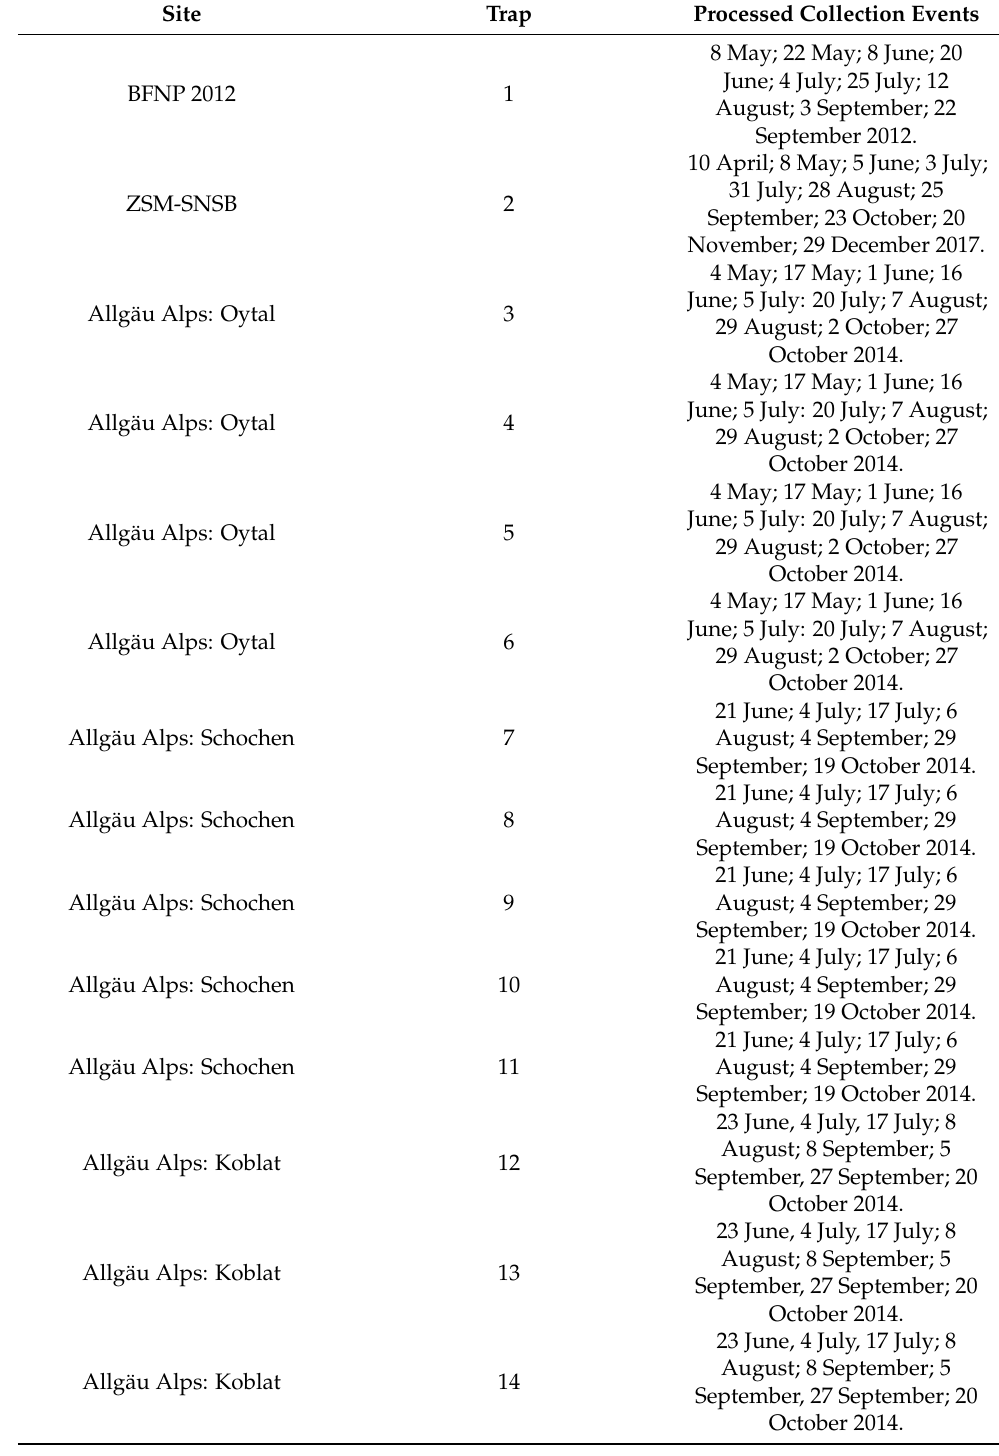
Table A1. Collection events for each Malaise